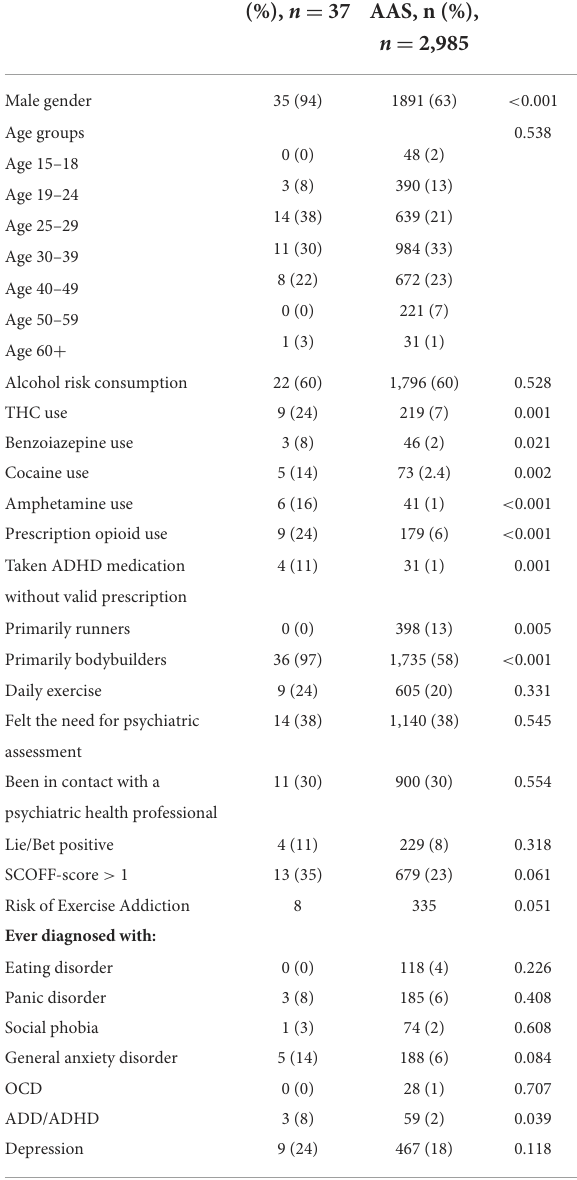
TABLE 3 Descriptive characteristics of 3,022 athletes who exercise more than three times a week comparing those who reported using anabolic androgenic steroids (AAS-use) to those reporting not using anabolic androgenic steroids the last year, p-value after using Fisher’s exact test.